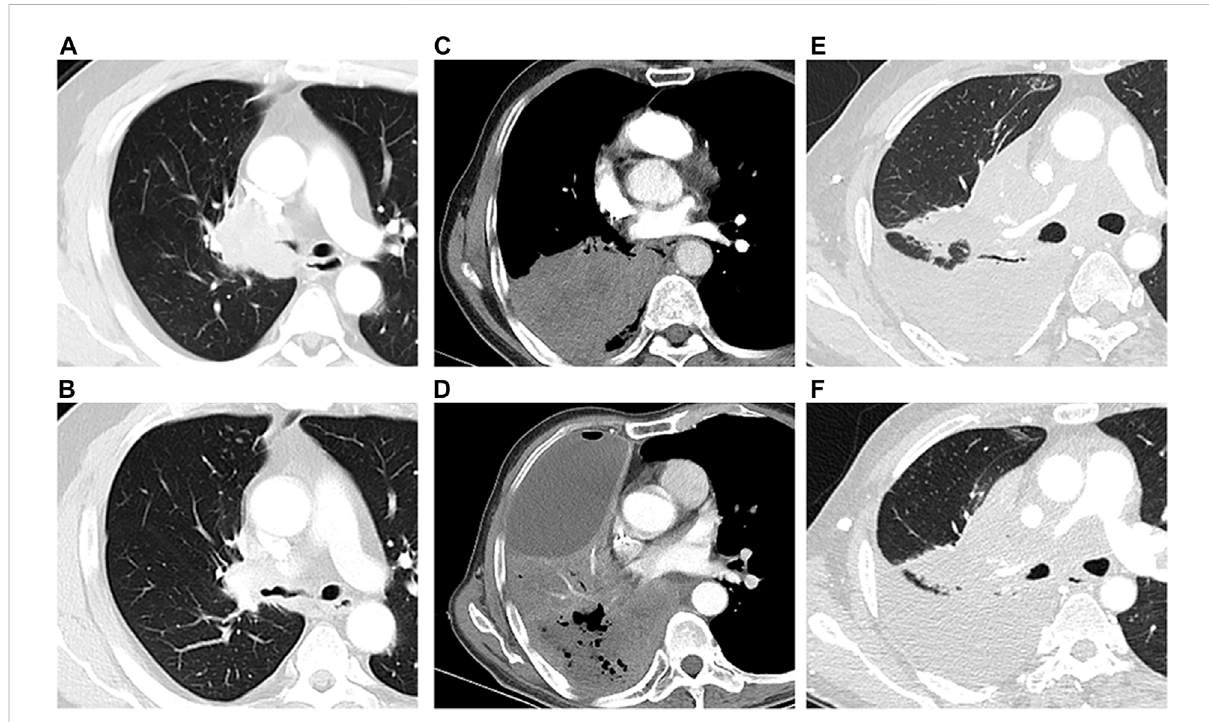
FIGURE 2 Tumor response after DEB-BACE. One patient with solid tumor mass (squamous cell carcinoma) ( A ) achieved PR 58 days after DEB-BACE ( B ); The tumor mass (squamous cell carcinoma) with central mild necrosis ( C ) did not respond to the DEB-BACE, and the necrosis area became more obvious withinprogressive lesions( D );Thelesion andobstructiveatelectasiswerestableinonepatientwithsquamouscellcarcinomabefore( E )and after ( F )